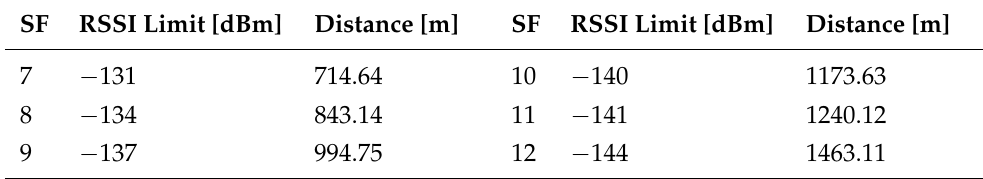
Table 3. Transmission distances for different